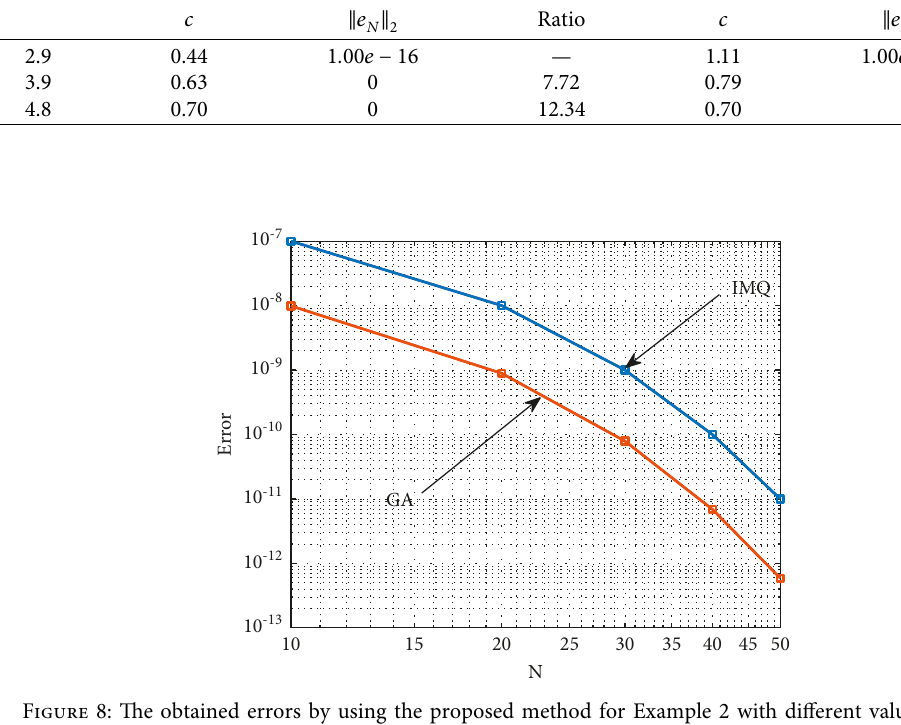
Table 4: Comparison of the obtained max error (‖ e